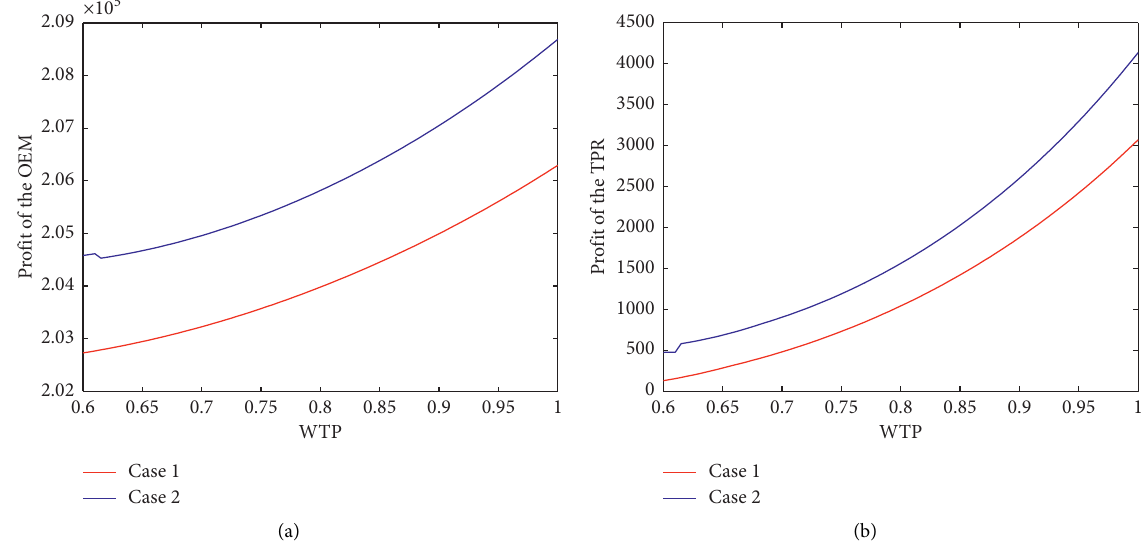
Figure 11: Profit of (a) the OEM and (b) the TPR vs.